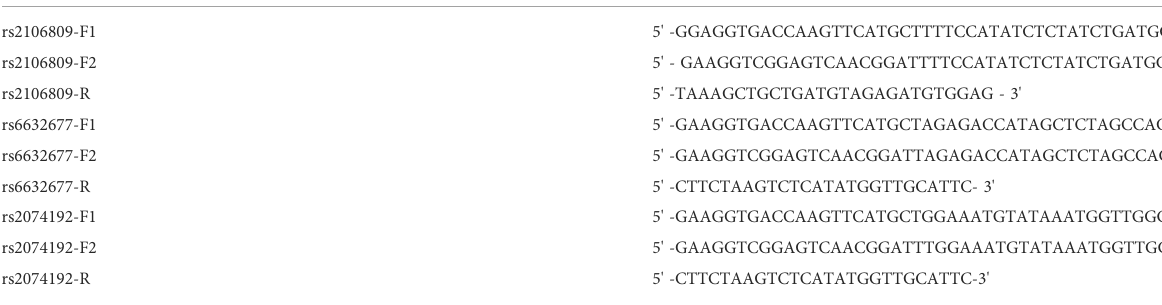
TABLE 1 The information of primer sequences for selected